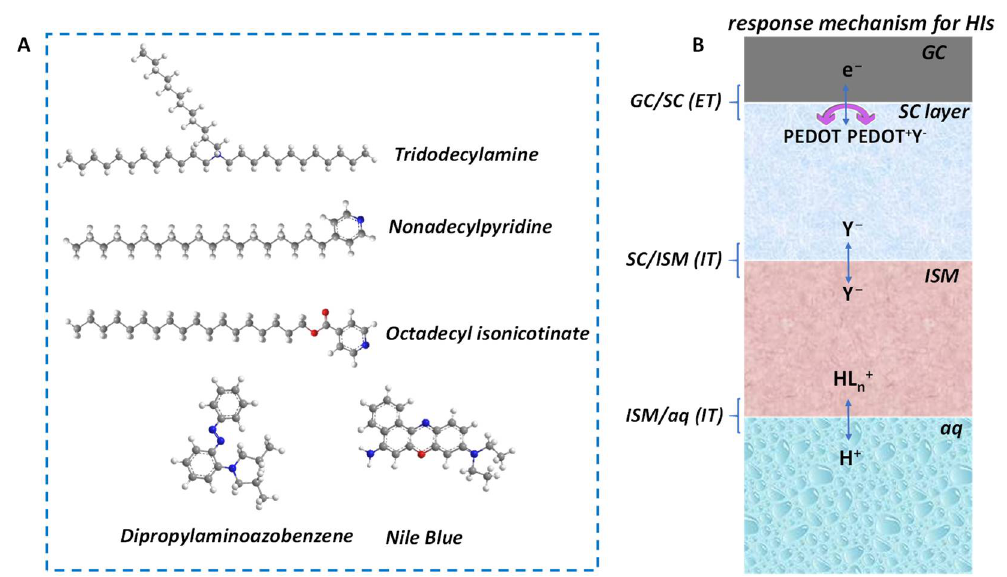
Figure 3. ( A ) Representative HIs include tridodecylamine, nonadecylpyridine, octadecyl isonico- tinate, dipropylaminoazobenzene and Nile blue. ( B ) The pH−response mechanism of HI−based SC−ISEs. GC—glass carbon electrode substrate; SC—solid contact; ISM—ion-selective membrane; ET—electron transfer; IT—ion transfer; aq—aqueous solution.